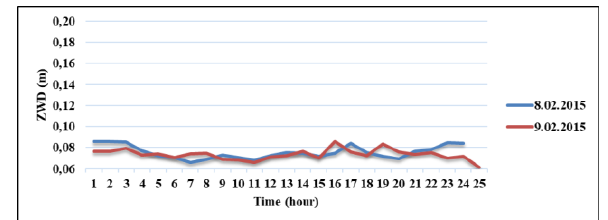
Figure 13. PM 10 time series of